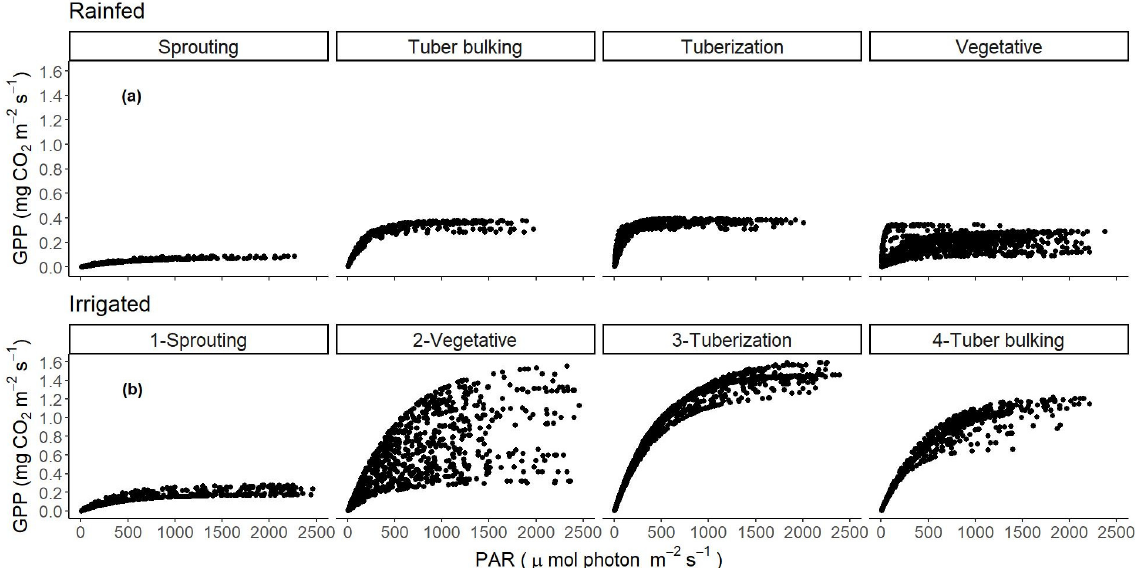
Figure 5. Half-hourly gross primary production (GPP) Versus incident PAR in four different growth stages (sprouting, vegetative, tuberization, tuber bulking) in ( a ) Rainfed and ( b ) Irrigated potato crop.